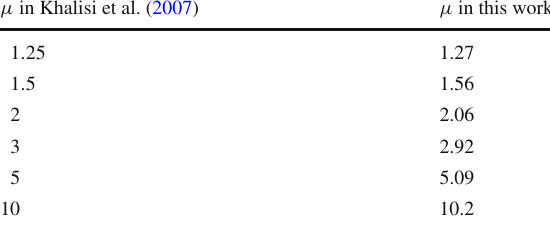
μ in Khalisi et al. (2007) μ in this